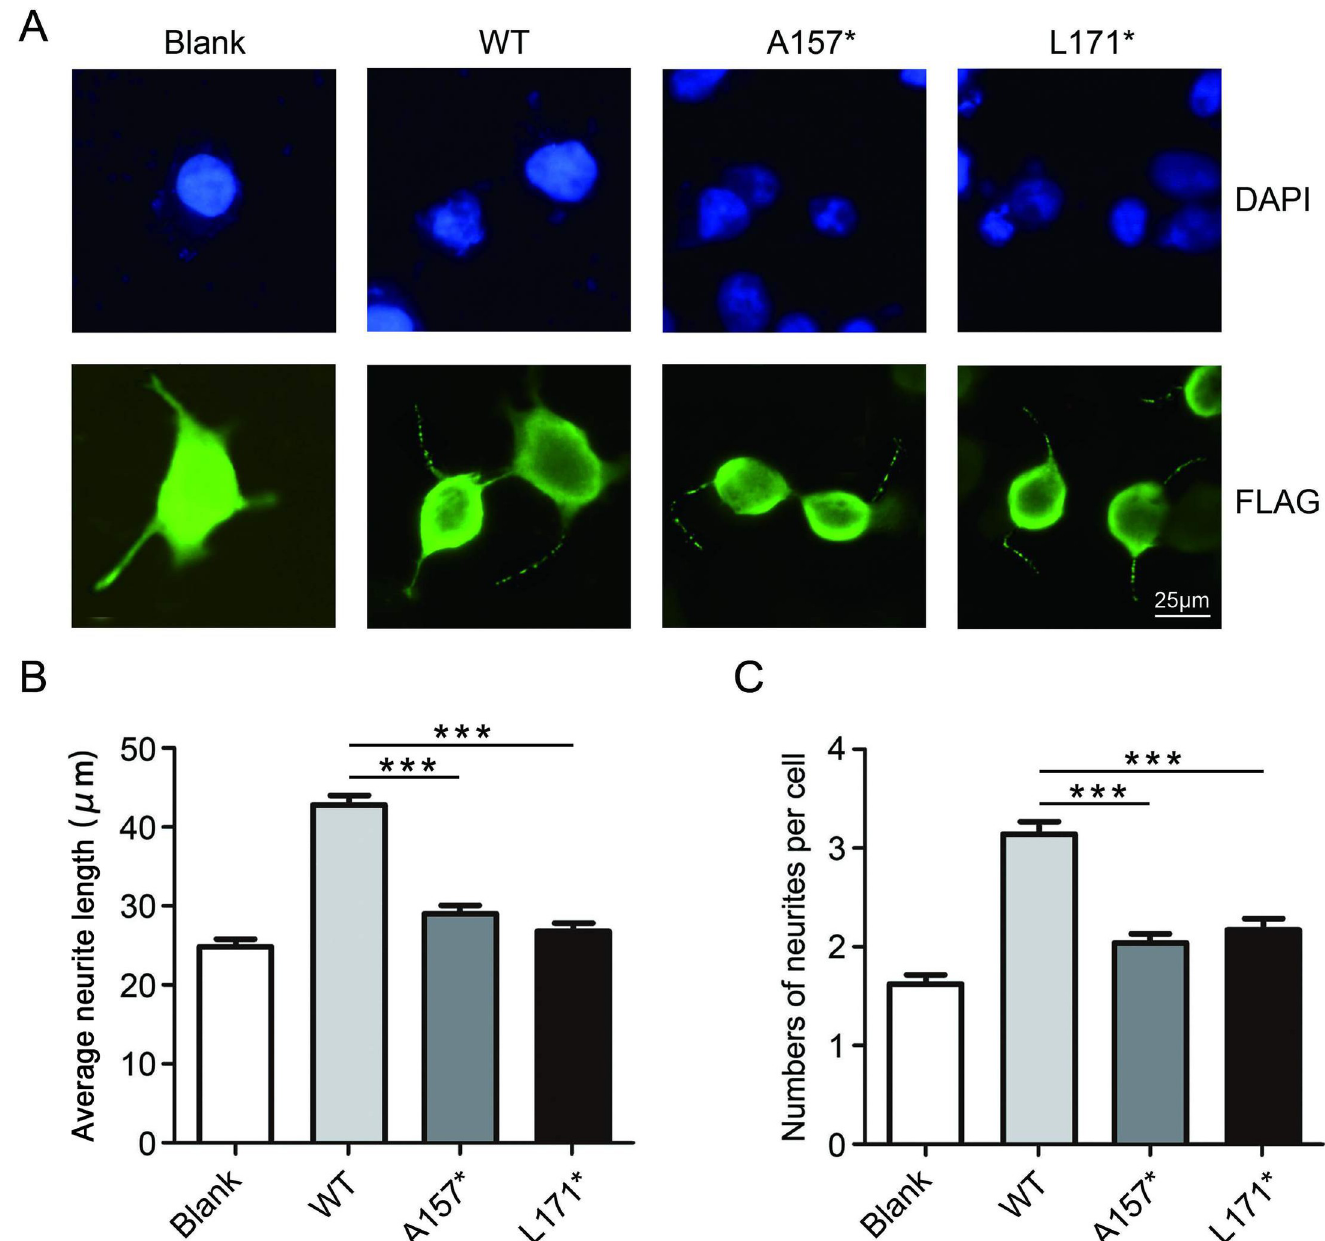
Fig 4. A157 � and L171 � mutants disrupt neurite outgrowth in neuro-2a cells. (A) Neuro-2a cells were transfected with the indicated constructs, and FLAG-positive cells were determined by immunofluorescent assays. (B) (C) The average length of each neurite and the numbers of neurites per cell were counted. One hundred neurites in FLAG-positive cells were scored for neurite outgrowth. Neurite numbers were counted in one hundred FLAG-positive cells. The data are presented as the mean ± SE ( ��� p < 0.0001).